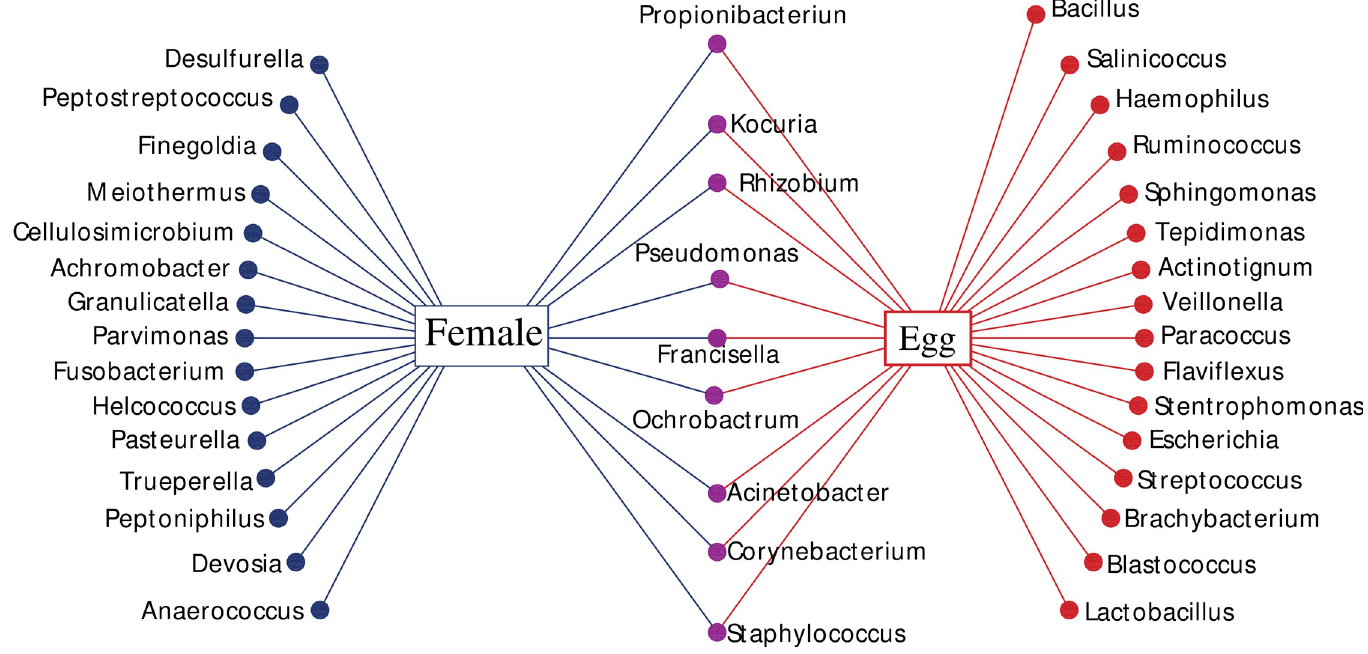
Fig 3. Network analysis showing the shared and non-shared H . anatolicum female gut and egg bacteria genera revealed by NGS.